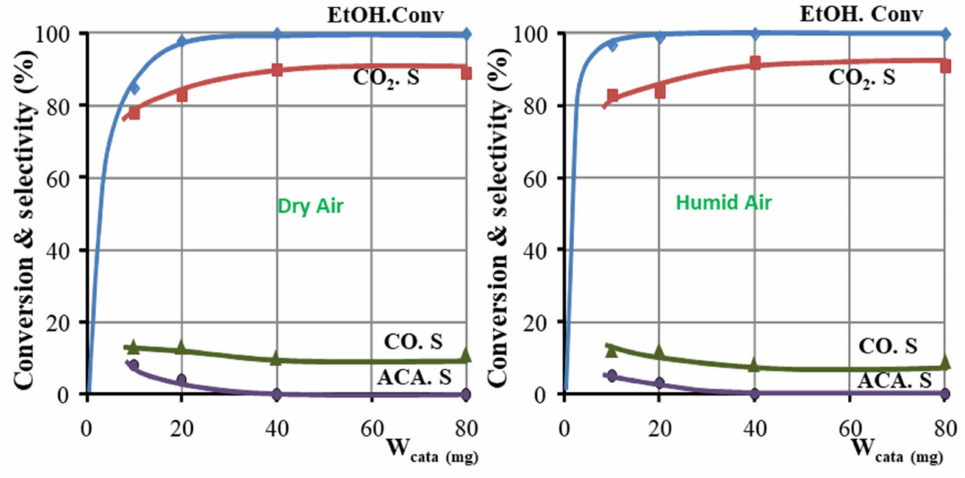
Figure 6. Influence of the mass of the 0.5Pd–5Mn/TiO 2 mM catalyst in powdered form under dry and humid (RH = 10%) conditions ([EtOH] = 10 ppm, [O 3 ] = 70 ppm, T = 60 ◦ C, Time = 3 h).